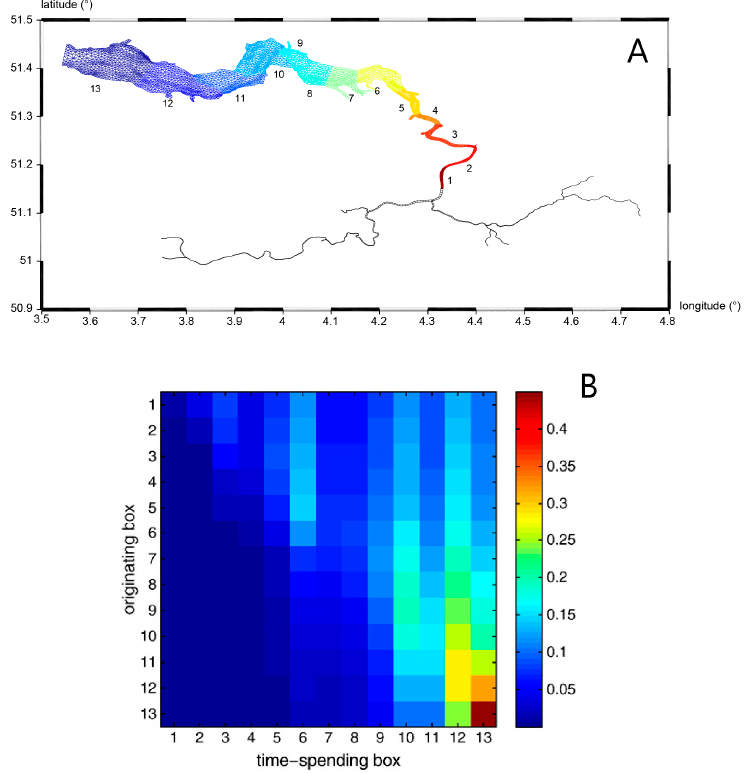
Figure 20. ( A ) Zoom-in of the computational mesh of De Brauwere et al. [95], showing subregions of the Scheldt Estuary referred to in ( B ). Subregions were based on the compartmentalization of [235]. ( B ) Connectivity matrix based on computations of “subdomain exposure times” with a 2D tracer transport model. Colors represent the relative time spent in a particular subregion numbered on the horizontal axis by tracer initialized in a subregion on the vertical axis. (Modified from De Brauwere [95], with permission from Elsevier).